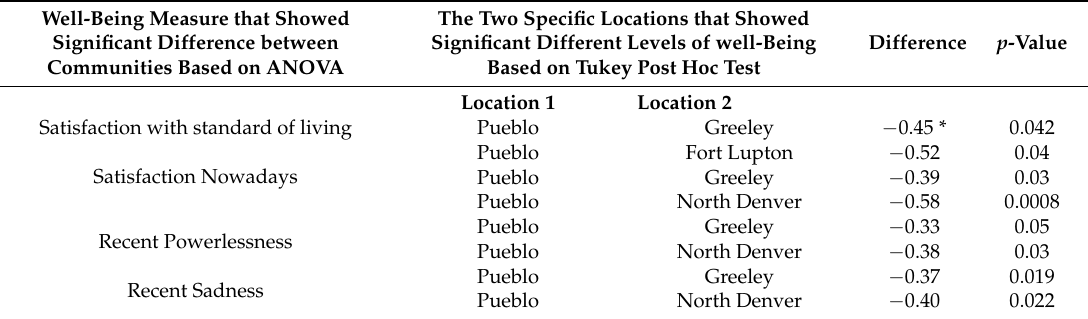
Table 9. The summary table of the Tukey Post Hoc Test results among communities’ well-being. Only significant results are